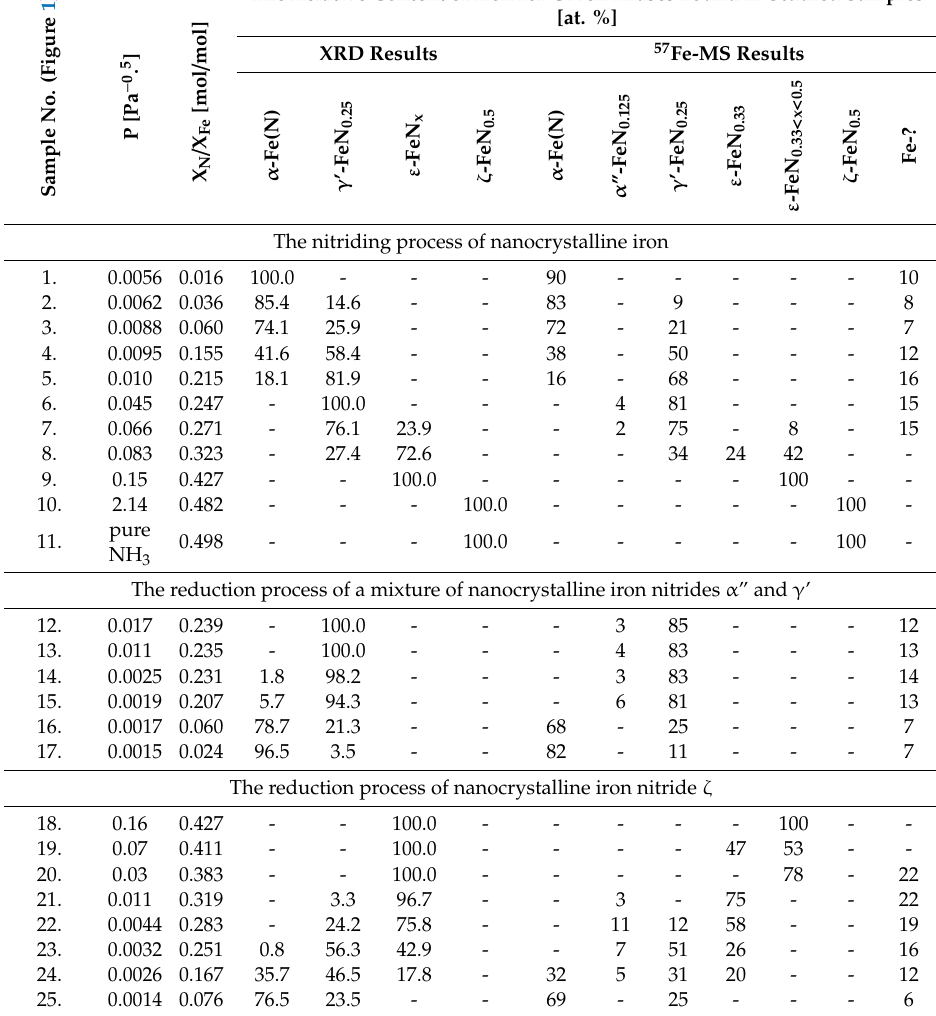
Table 2. The comparison of iron content (distribution) for the phases found in studied samples according to the X-ray di ff raction (XRD) and 57 Fe Mössbauer spectroscopy (MS) methods. The Relative Content of Iron for Given Phases Found in Studied Samples [at.